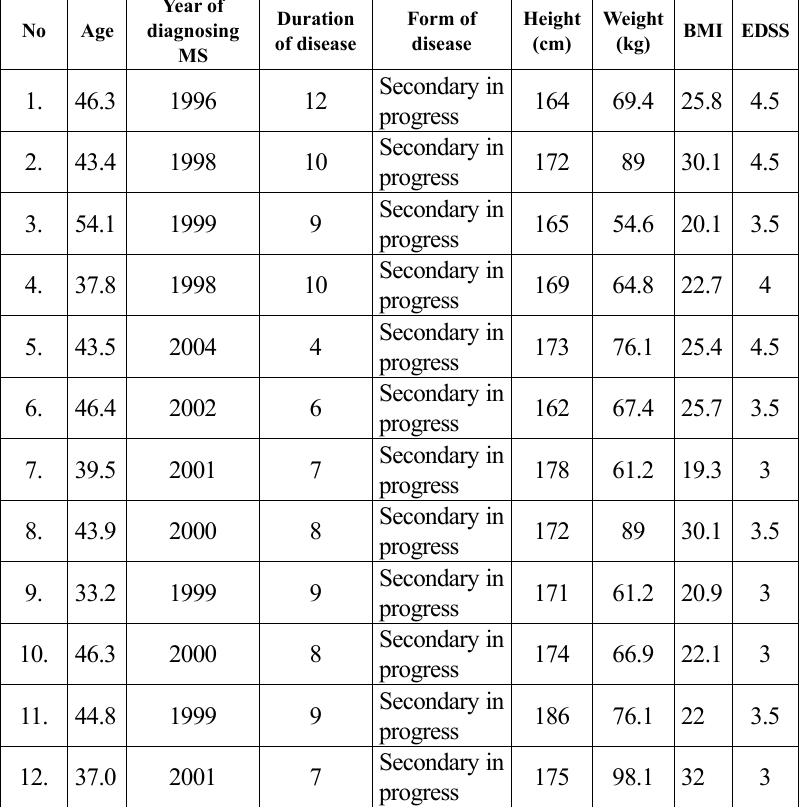
Table. Data of women with multiple